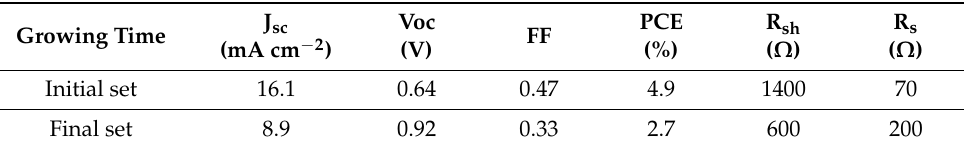
Table 7. Performances of perovskite solar cells fabricated with different NW growing parameters (i.e., initial and final